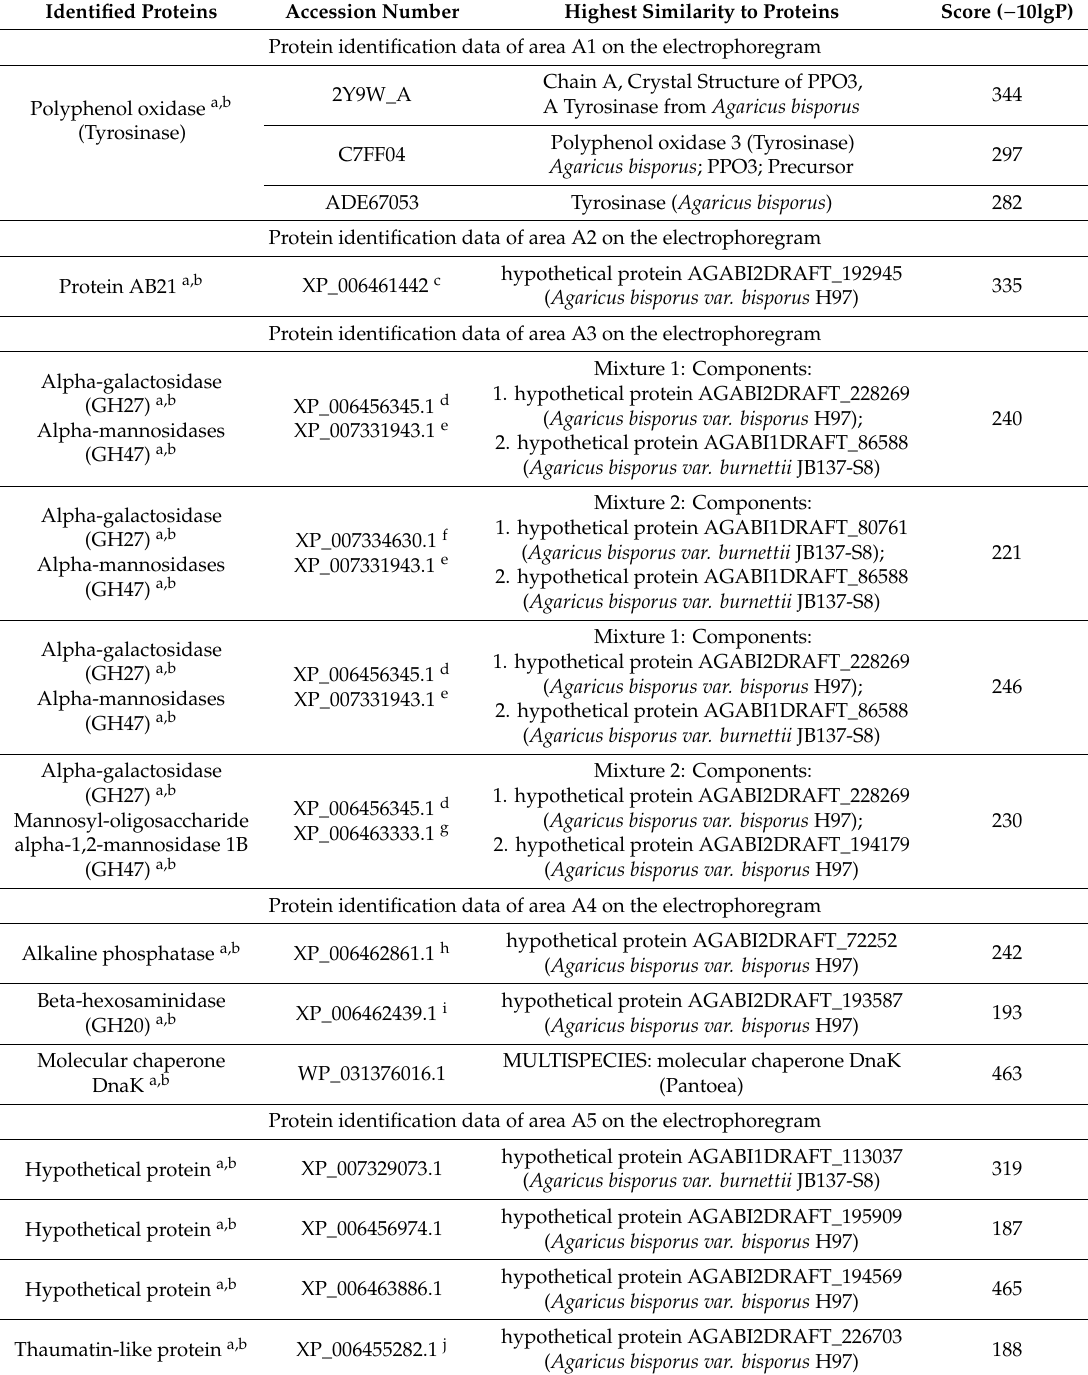
Table 1. Proteins identified by MALDI TOF / TOF mass spectrometry in Agaricus bisporus crude extract